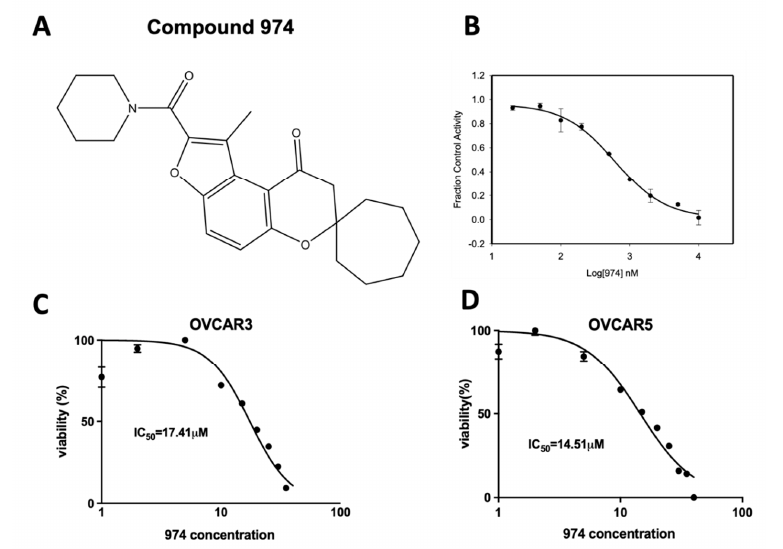
Figure 1. Compound 974: A novel ALDH1A1 inhibitor . ( A ) Chemical structure of compound 974. ( B ) EC50 curve for 974 binding with purified ALDH1A1. ( C ) OVCAR3 (D) OVCAR5 were treated with increasing doses of 974 (0.5–100 µM) for 48 h, and an MTT assay was performed to measure viability. IC 50 values were calculated using GraphPad Prism.